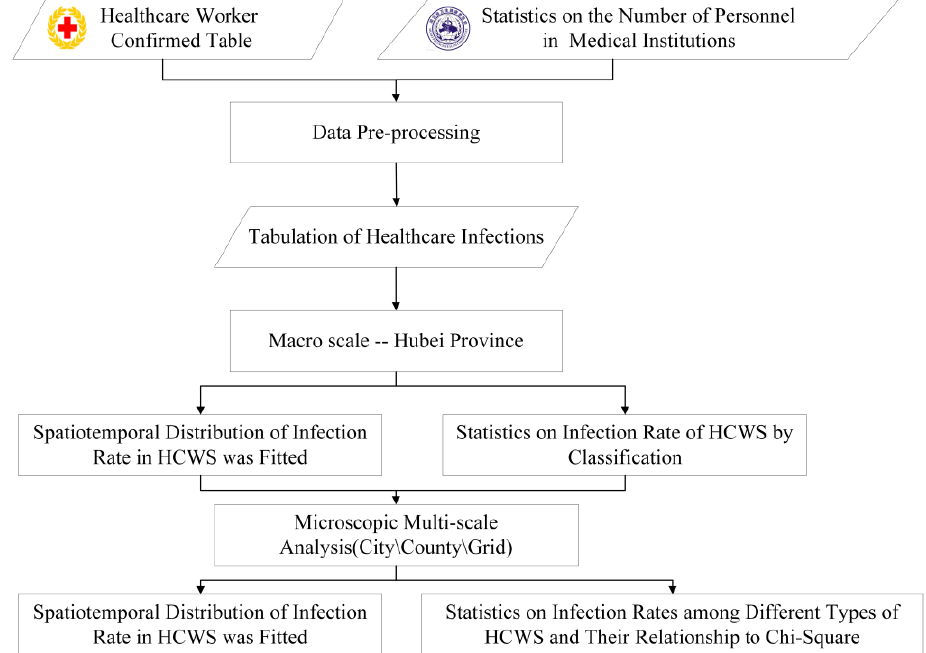
Figure 2. Research flow chart.